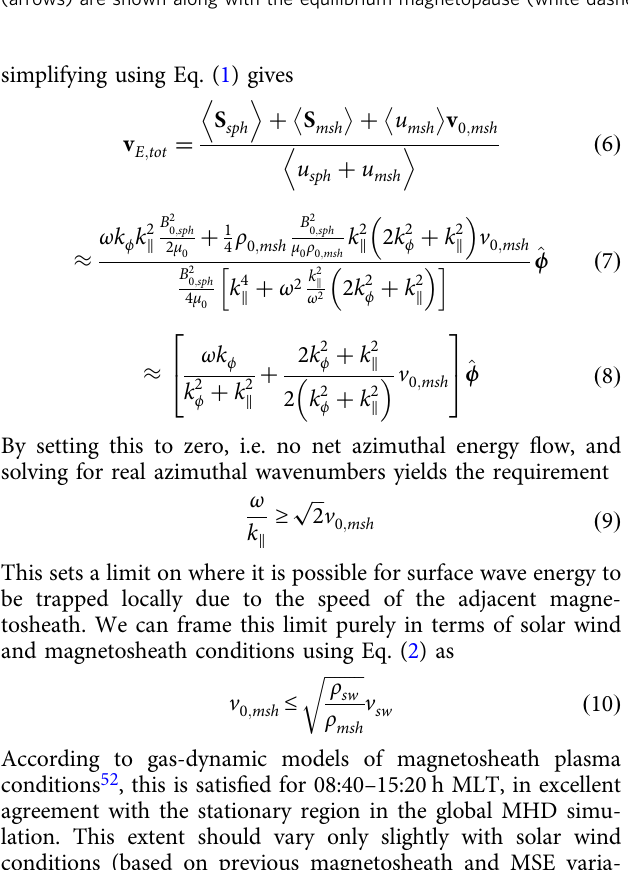
Fig. 7 Wave energy fl ux maps. Panels show time-averaged wave Poynting ( a ), advective ( b ) and total ( c ) energy fl uxes. Magnitude (colour) and direction (arrows) are shown along with the equilibrium magnetopause (white dashed) and virtual spacecraft location from Fig. 6